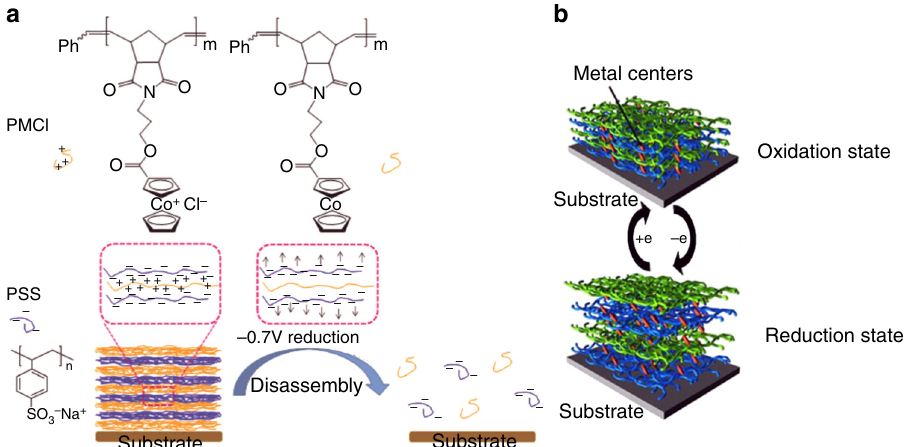
Fig. 4 Controlled disassembly and controlled swelling of metallo-polyelectrolyte based PEMs. a reduction-induced disassembly of cobaltocenium-based PEMs 65 , adapted from ref. 65 with permission from The Royal Society of Chemistry; b a strategy used in controlled swelling of PEMs 72 , adapted from ref. 72 with permission,